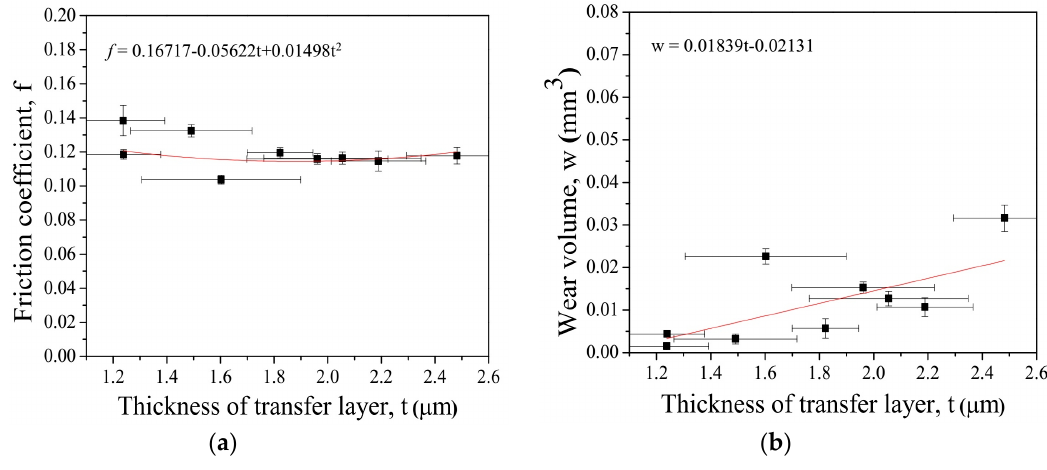
Figure 11. Relationships between tribological properties and transfer layer thickness: ( a ) Friction coefficient, ( b ) wear volume.